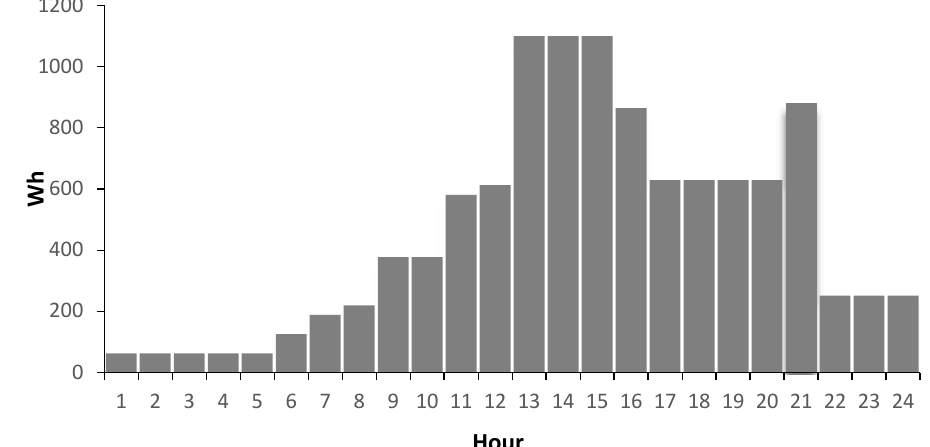
Figure 4. AC loads in a house throughout the year on an hourly basis.